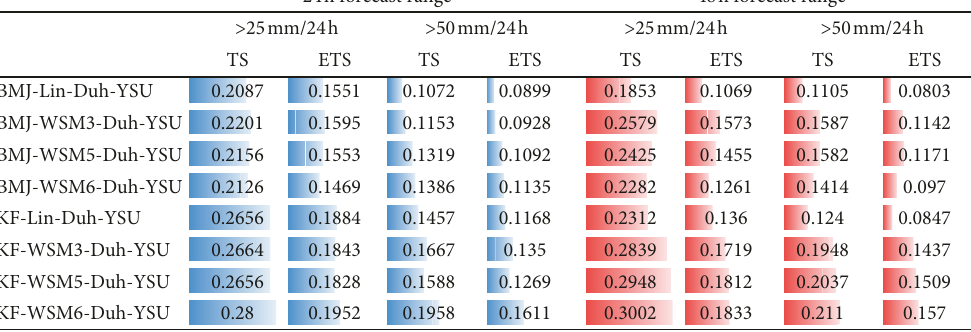
Figure 7: Brief comparison of TSs and ETSs for illustration of sensitivities with microphysics schemes.